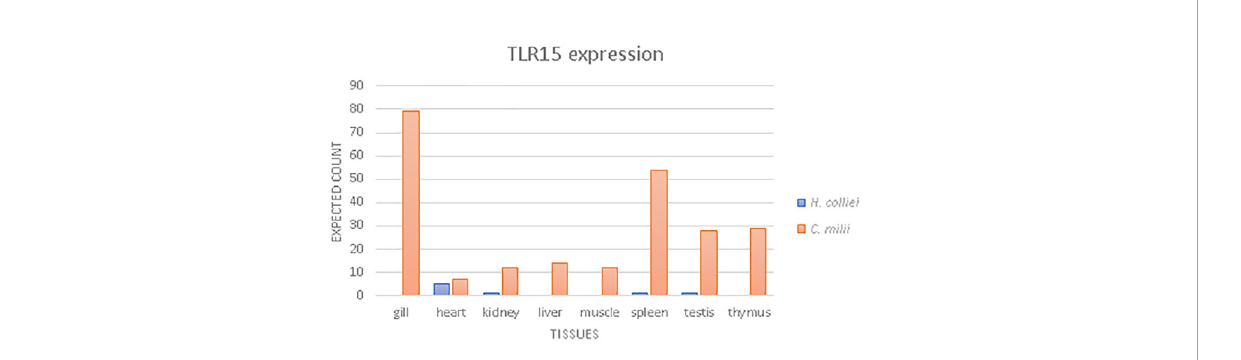
FIGURE 3 TLR15 gene expression analysis, based on the expected reads counts estimated with RSEM for Australian ghost shark ( C. milii ) and spotted rat fi sh ( H. colliei